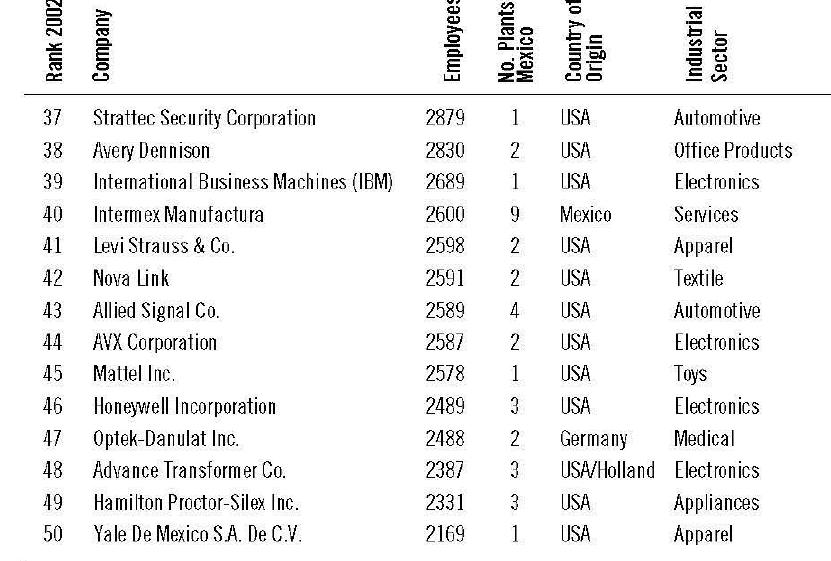
Table 2 - Mexico's Fifty Largest